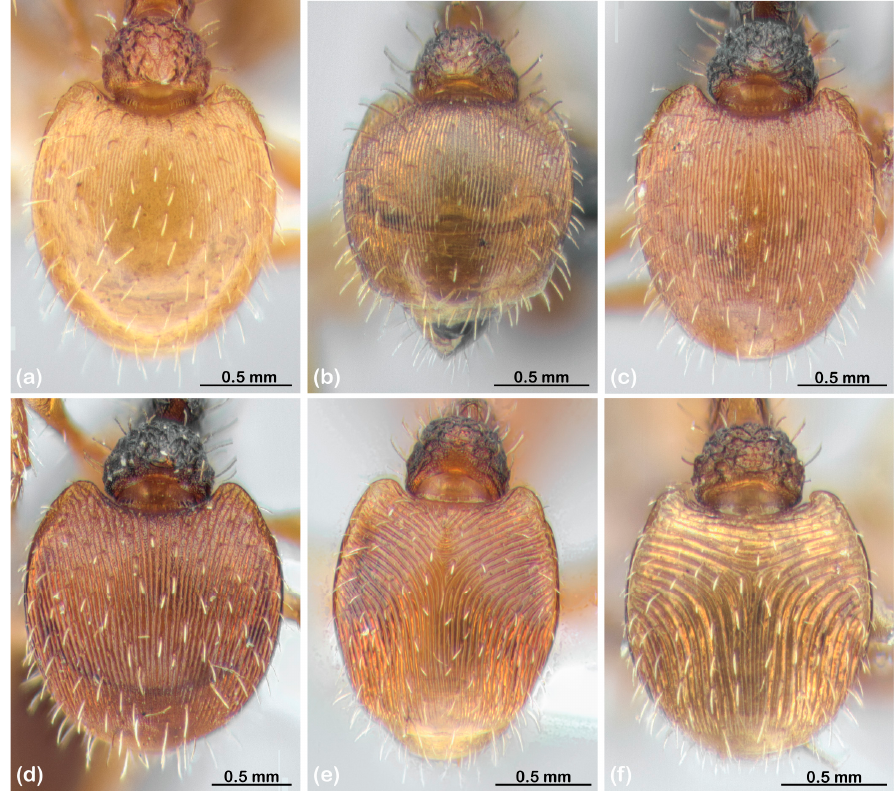
Figure 3. Variation in gastric sculpture among species of the T . spininode group from the NT. Species are arranged with increasing sculptural coarseness. ( a ) sp. 15; Arnhem Land, NT (not sequenced). ( b ) sp. 21; OZBOL 8250-22. ( c ) sp. 20; TET 086-17. ( d ) sp. 14; TET 088-17. ( e ) sp. 11; Manbulloo Stn, NT (not sequenced); ( f ) sp. 5; OZBOL